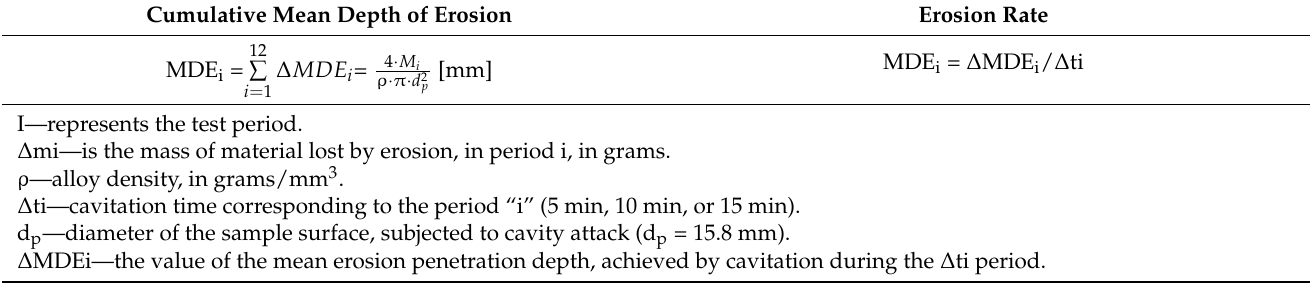
Table 2. ASTM G32-2016 parameters for evaluating the resistance and behaviour to cavitation erosion. Cumulative Mean Depth of Erosion Erosion Rate